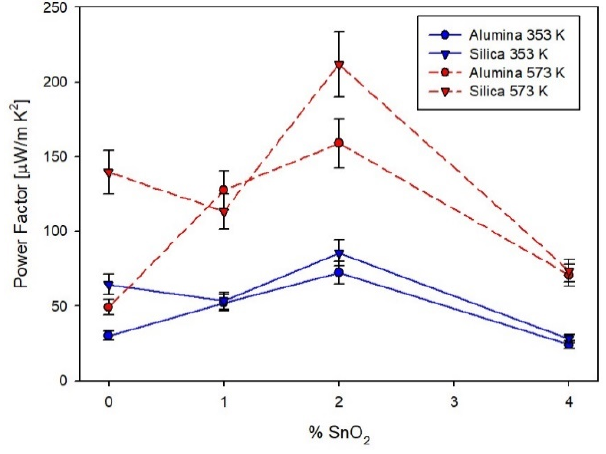
Figure 10. The trend of power factor with the content of SnO 2 for the two series of films on silica and alumina.